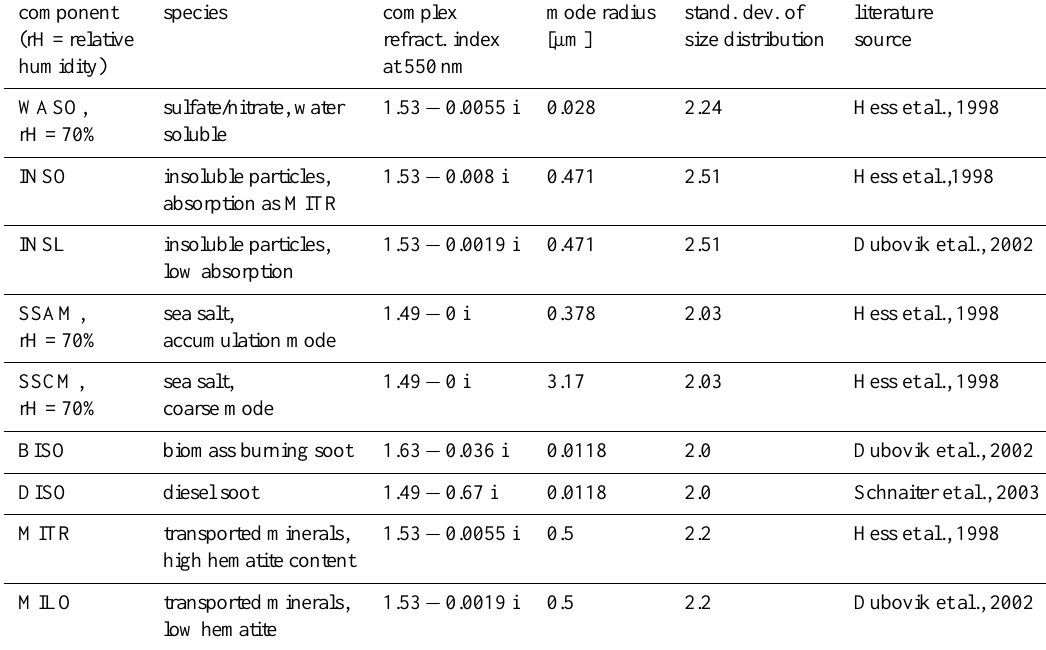
Table 1. Optical characteristics of basic components used for external mixing in SYNAER (Holzer-Popp et al., 2008). component species complex mode radius stand. dev.